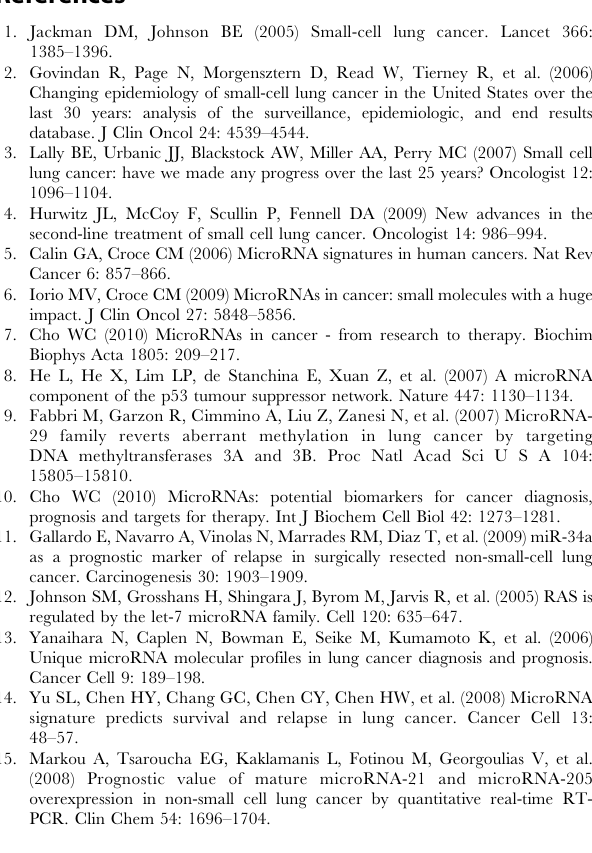
Figure S1 Expression of microRNAs in SCLC versus in NSCLC cell lines. A delta Ct value of 2 15 indicates that the expression of the microRNA in the cell is too low to be detected. (TIF) Figure S2 in situ hybridization of microRNAs in a SCLC tumor . Nucleolar RNA U6 and miR-34b were detected using a biotinyl tyramide-based system with Vector NovaRed as a substrate (brown). Specimens for scramble negative control and miR-34b were co-stained with Mayer’s hematoxylin (blue). (TIF) Figure S3 Correlation of expression of p53 and (A) miR- 34a, (B)miR-34b, and (C) miR-34c, and (D) correlation of expression of miR-34a and bcl-2. Expression of p53 and bcl- 2 were presented as percentage of stained cells by immunohisto- chemistry. Correlation coefficient (r) and p-value were determined by Spearman method. (TIF) Figure S4 NCI-H82 cell transfected with (A) Cy3-labeled microRNA inhibitor and (B) Cy3-labeled microRNA precursor. (TIF) Figure S5 Cell growth assay of NCI-H1299 NSCLC cells transfected with miR-34a or control precursor. Error bars refer to standard deviations. (TIF) Figure S6 Growth inhibition assay of the GLC4 cells treated with (A) cisplatin and (B) etoposide. Cells were